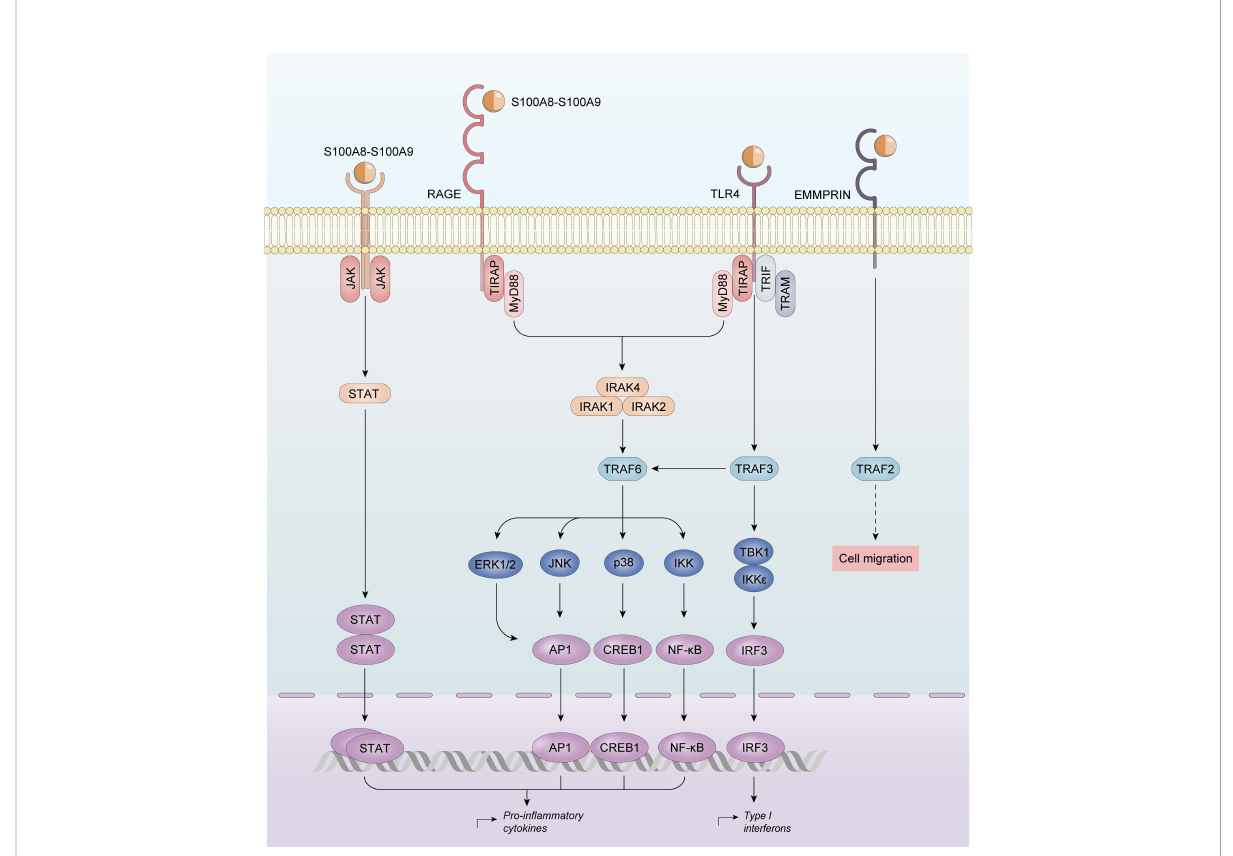
FIGURE 2 Calprotectin activation in Rheumatoid Arthritis. Calprotectin activates nuclear factor k B (NF- k B), and protein kinase-mediated signal transduction pathways, including c-Jun-N-amino-terminal kinase (JNK), extracellular-regulated kinase 1/2 (ERK1/2), and Janus kinase/signal transducers and activators of transcription (JAK/STAT) upregulating proin fl ammatory cytokines